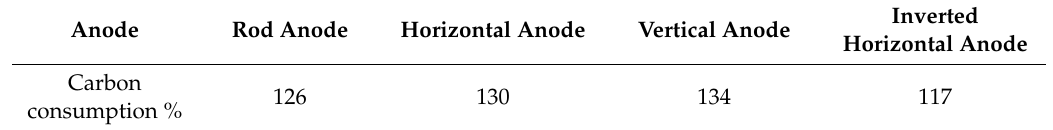
Table 1. Carbon consumption for the different anode designs.